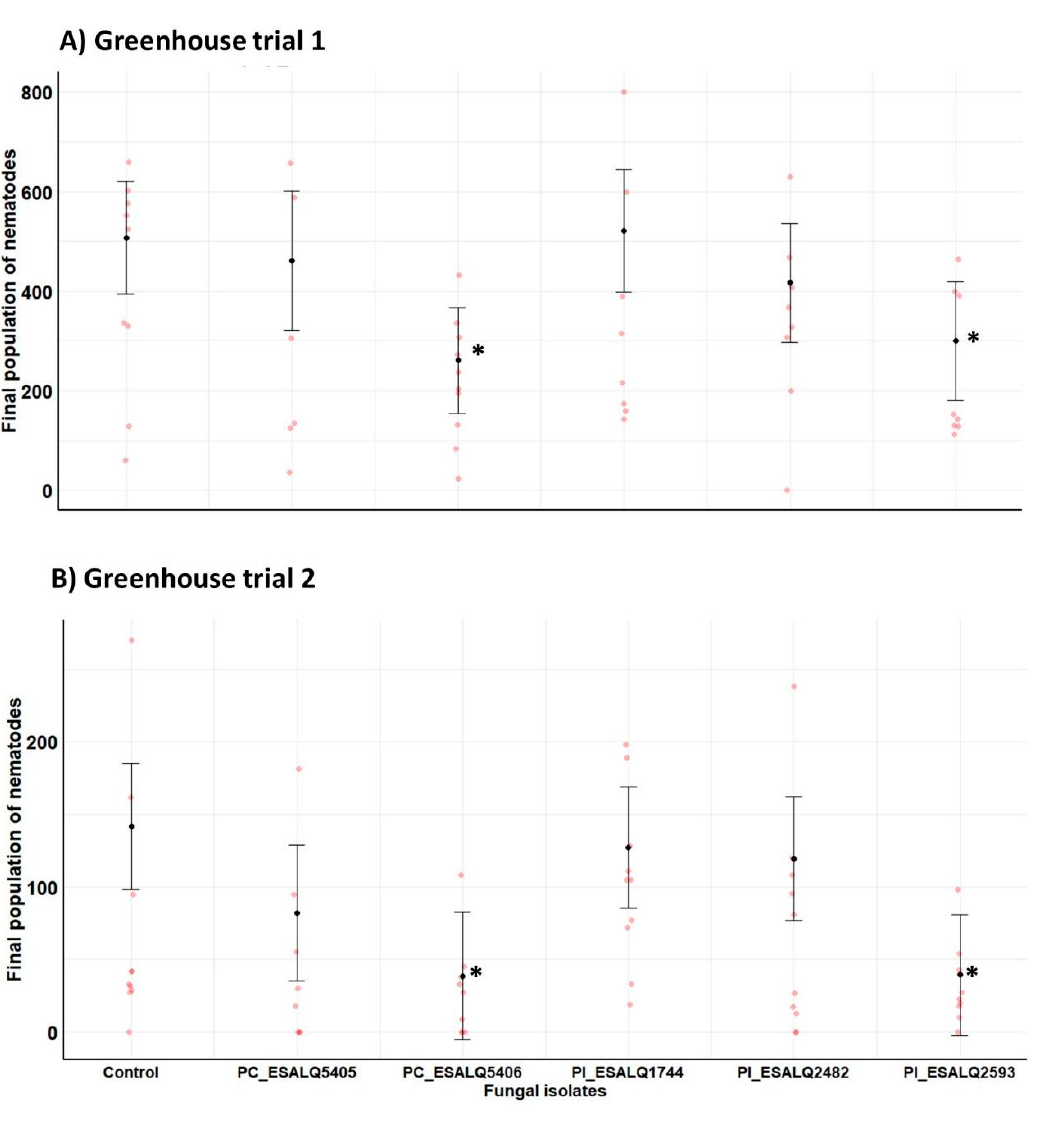
Figure 6. Impact of Purpureocillium lilacinum (Pl) and Pochonia chlamydosporia (PC) isolates on the final population of the soybean cyst nematode Heterodera glycines in total fresh root mass from potted bean plants at 45 days after fungal inoculation and seeding under greenhouse conditions. Means with 95% confidence intervals ( n = 10 plants per treatment in red symbols) followed by asterisks (*) are significantly different from untreated control plants infested only with the cyst nematode (Likelihood ratio test at p < 0.05).